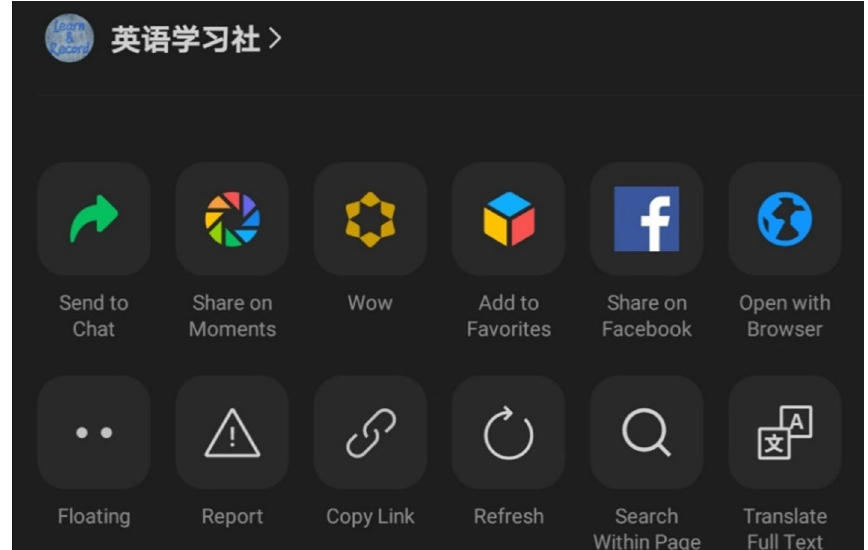
Fig. 17 Users can share articles and learning resources on their moments